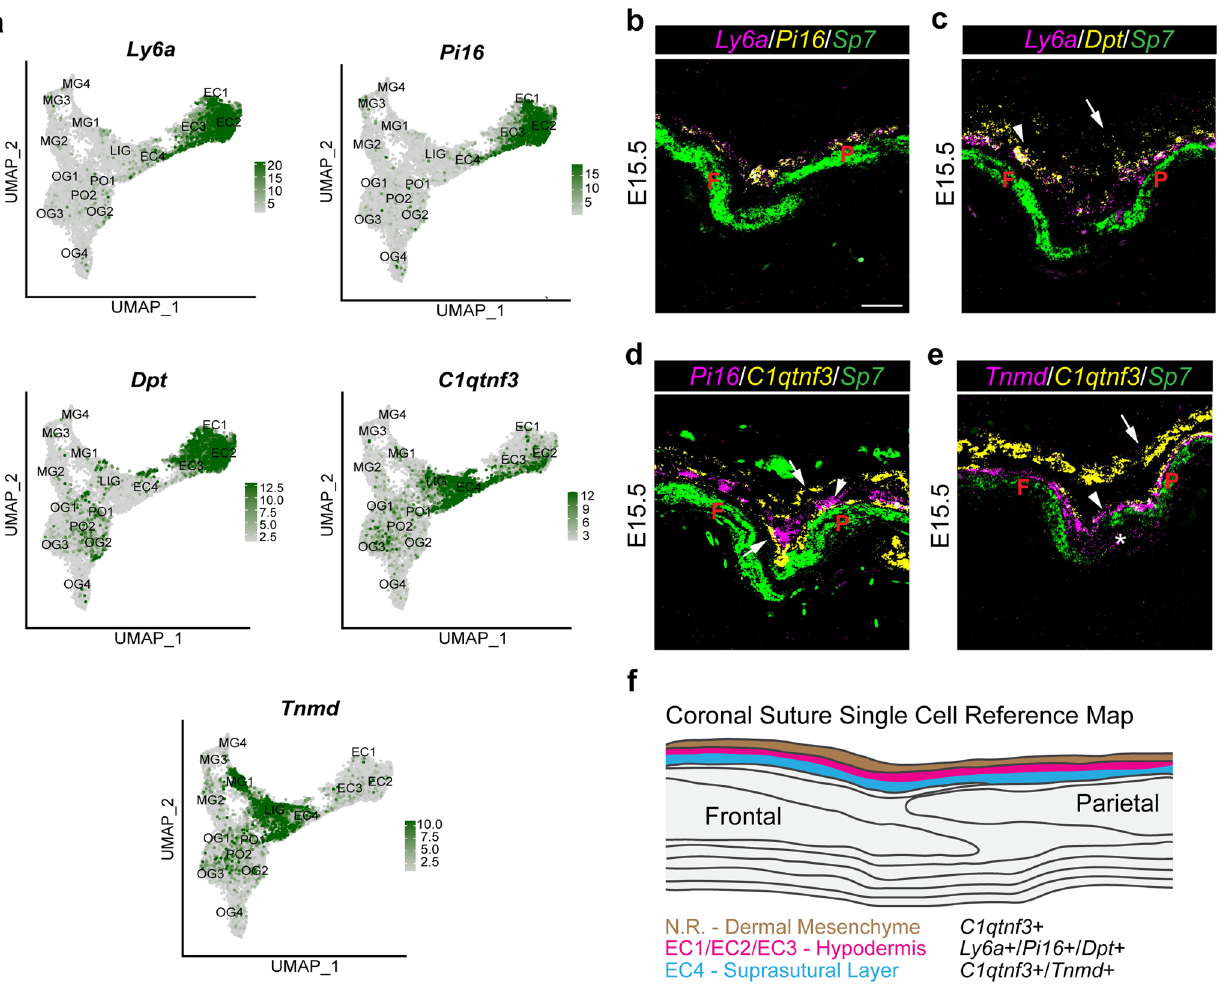
Fig. 3 Multiple ectocranial layers overlay the coronal suture. a Feature plots of genes validated by in situ experiments. b – e Combinatorial in situ analysis of coronal sutures for indicated markers at E15.5. Sp7 marks the frontal (F) and parietal (P) bones. b Ly6a and Pi16 . c Ly6a and Dpt . Arrow, Dpt + ; arrowhead, Ly6a + / Dpt + . d Pi16 and C1qtnf3 . Arrows, C1qtnf3 + layers; Arrowhead, Pi16 + layer. e Tnmd and C1qtnf3 . Arrow, C1qtnf3 + ; arrowhead, Tnmd + / C1qtnf3 + . Asterisk, Tnmd expression in MG1. f Model summarizing gene expression patterns of ectocranial layers captured from single-cell analysis. In situs were performed in biological triplicate. Scale bars = 50 µ m; images in ( b – e ) are at the same magni fi